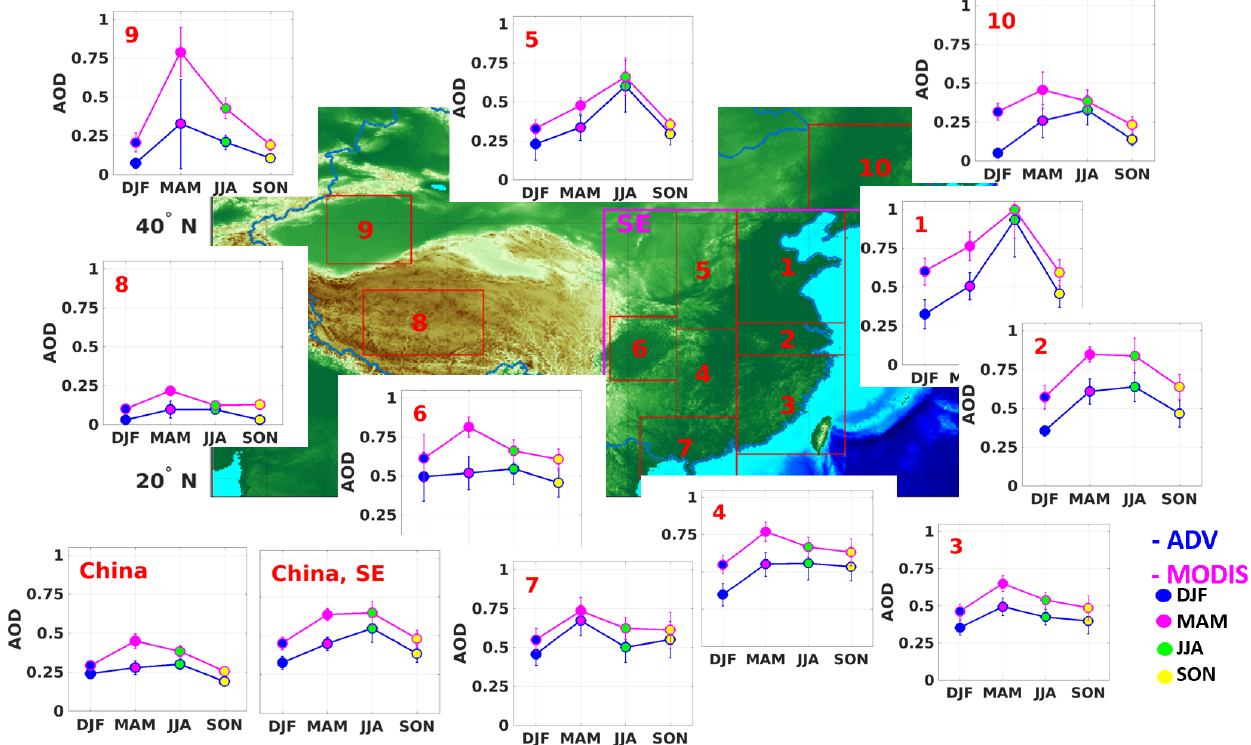
Figure 11. AOD seasonal time series averaged over the 2000–2011 period for ADV and MODIS (see legend for explanation) for China, SE China and the 10 selected regions as discussed in Sect. 2. Error bars shown on each seasonal data point are 1 σ standard deviation.